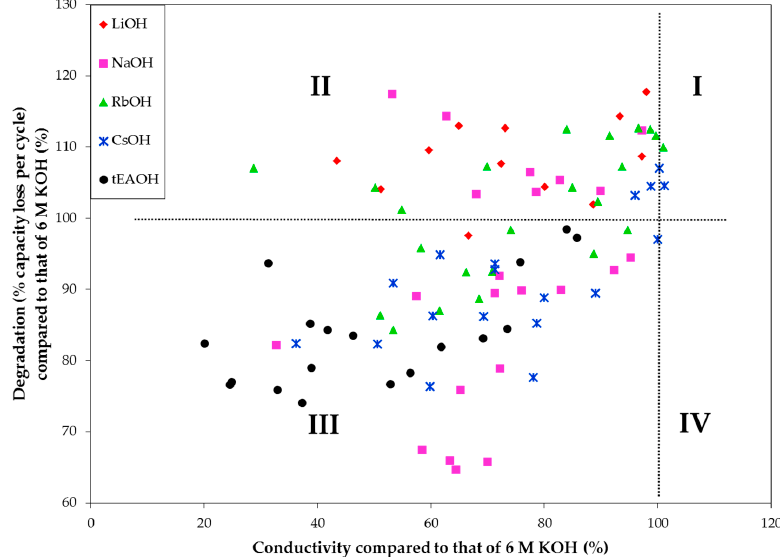
Figure 15. Plot of the degradation performances vs. the conductivities for various hydroxide aqueous solutions. Both quantities are normalized to those of 6 M KOH aqueous solution. Vertical and horizontal lines corresponding to the values from standard 6 M KOH aqueous solution divide the plot into Quadrants I, II, III, and IV. While the solutions in Quadrant II are less desirable (lower conductivity and higher degradation), those in Quadrant III represent a compromise between conductivity and degradation (lower conductivity and lower degradation). Future research will focus on finding solutions in Quadrant IV. Data originate from Appendix.